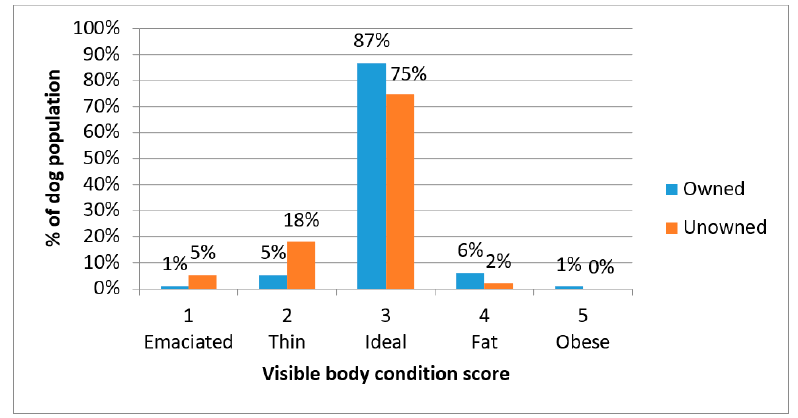
Figure 5. Percentage of owned and unowned dogs observed with body condition scores 1 (emaciated) through to 5 (obese).